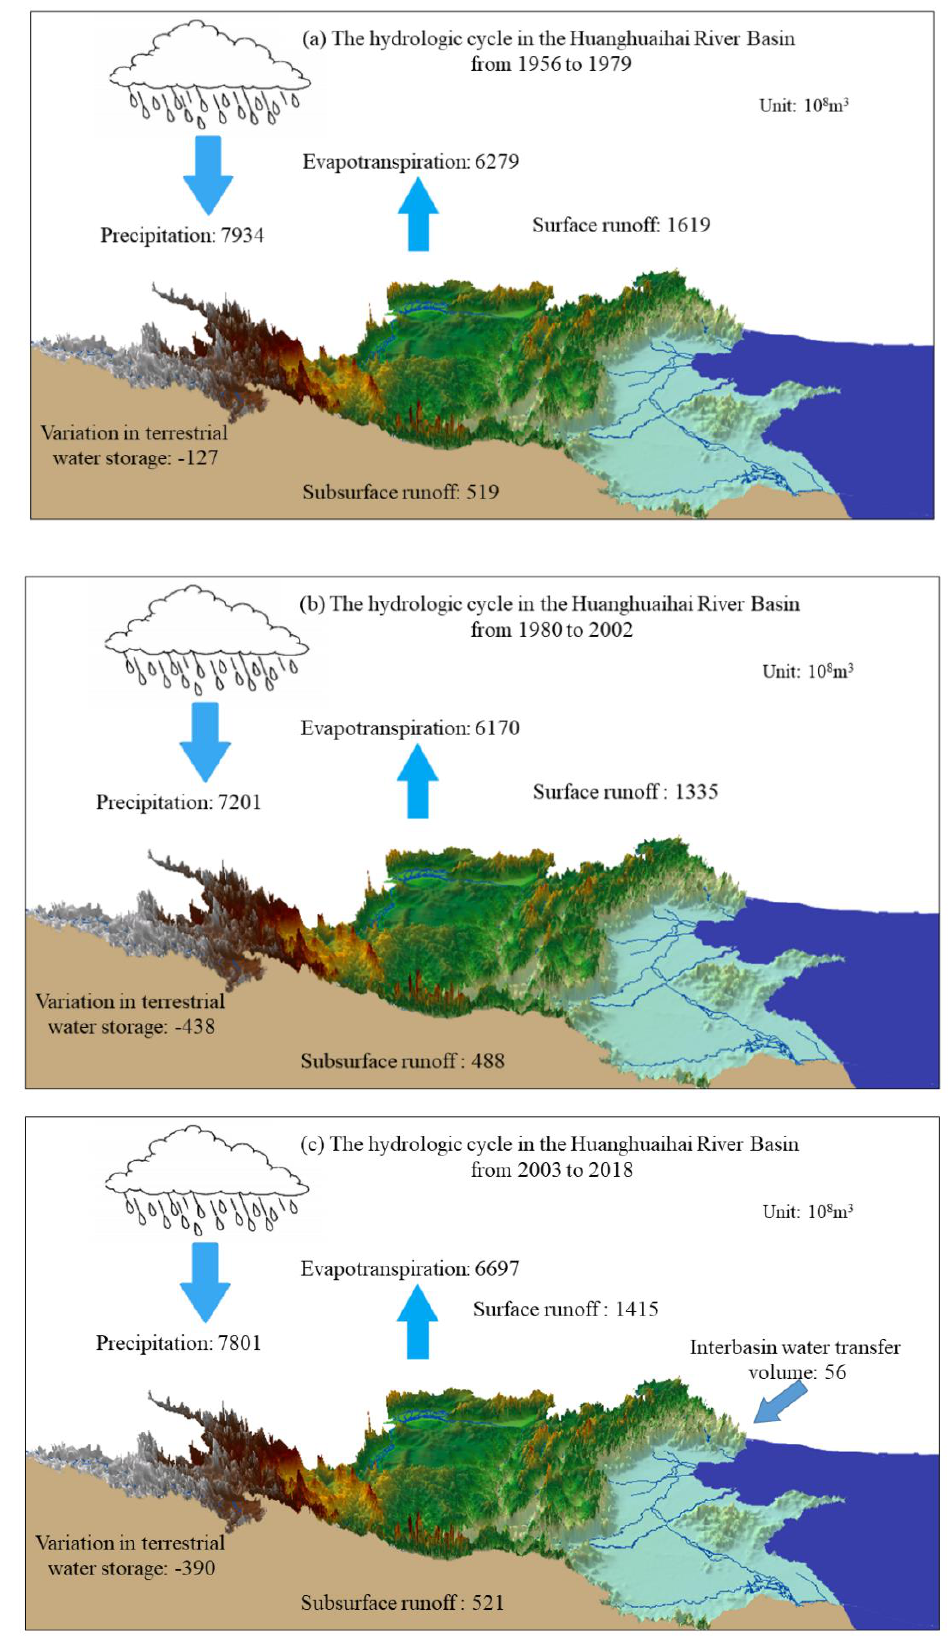
Figure 7. Diagram of water cycle in the